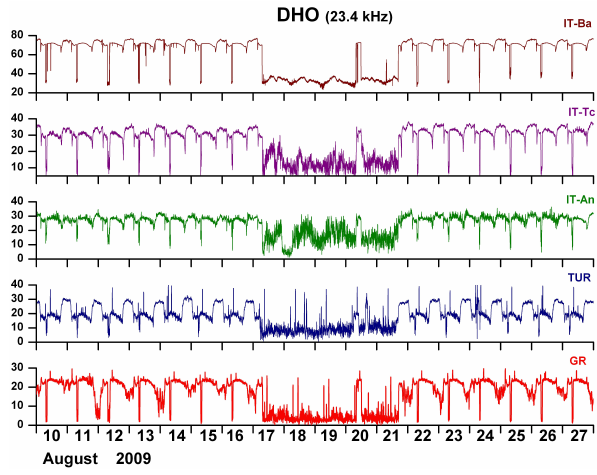
Fig. 7. Trends of the intensity of the HWU (21.75kHz) radio sig- nal collected by IT-An, TUR and ROM receivers during 1–10 June, 2010. Starting from 5 July, a change in all the trends appears. At ROM the quality of reception increases clearly; a little improvement happens at IT-An, while the reception turns bad at TUR, where the signal becomes